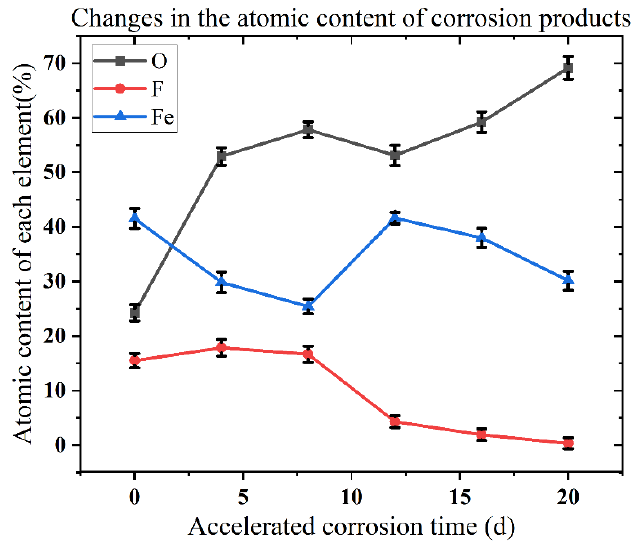
Figure 11. Changes in the elemental content of the corrosion products of Q235 low-carbon steel after different exposure times in accelerated corrosion environments.